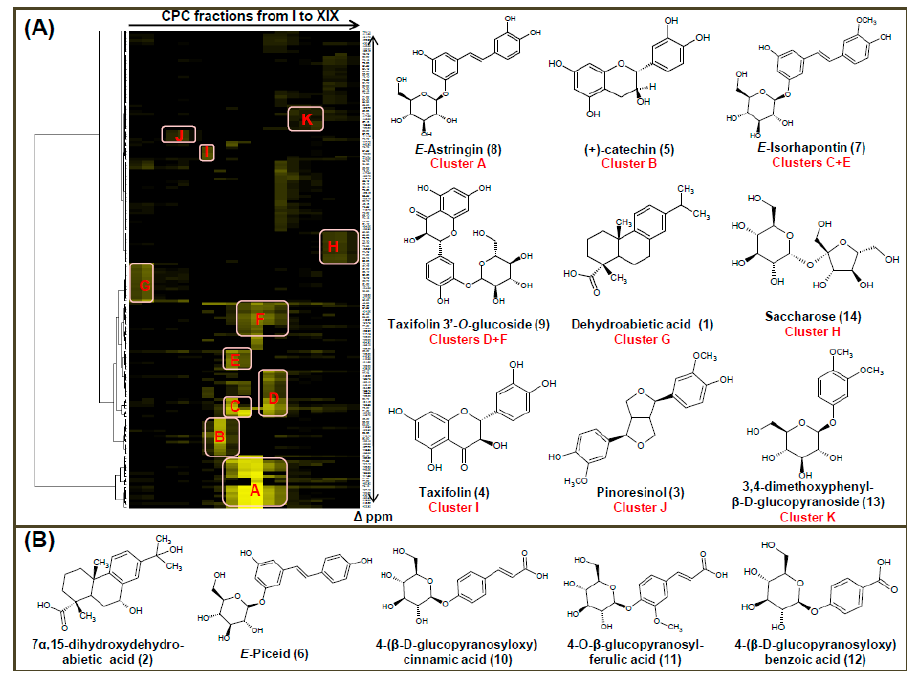
Figure 2. ( A ) 13 C-NMR chemical shift clusters (yellow color) obtained by applying HCA on CPC fractions of P. abies bark extract and the chemical structures of nine major compounds identified by database analysis of the marked clusters (clusters A to K). ( B ) Chemical structures of five minor compounds identified on CPC fractions by 2D-NMR analysis.